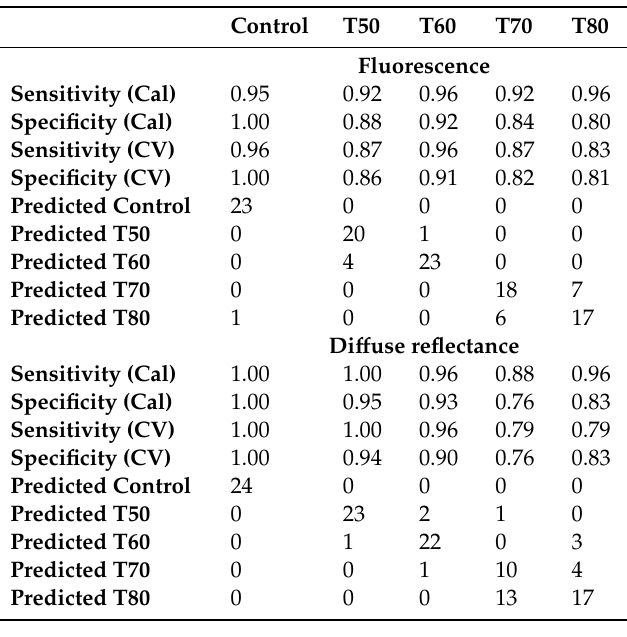
Table 2. Results of Partial Least Square Discriminant Analysis (PLS-DA) models applied to the fluorescence and di ff use reflectance data